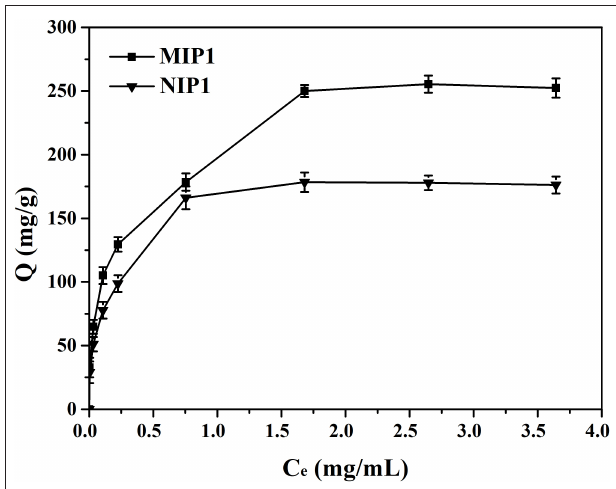
FIGURE 6 | Adsorption isotherms of MIP1 and NIP1 for ACT.